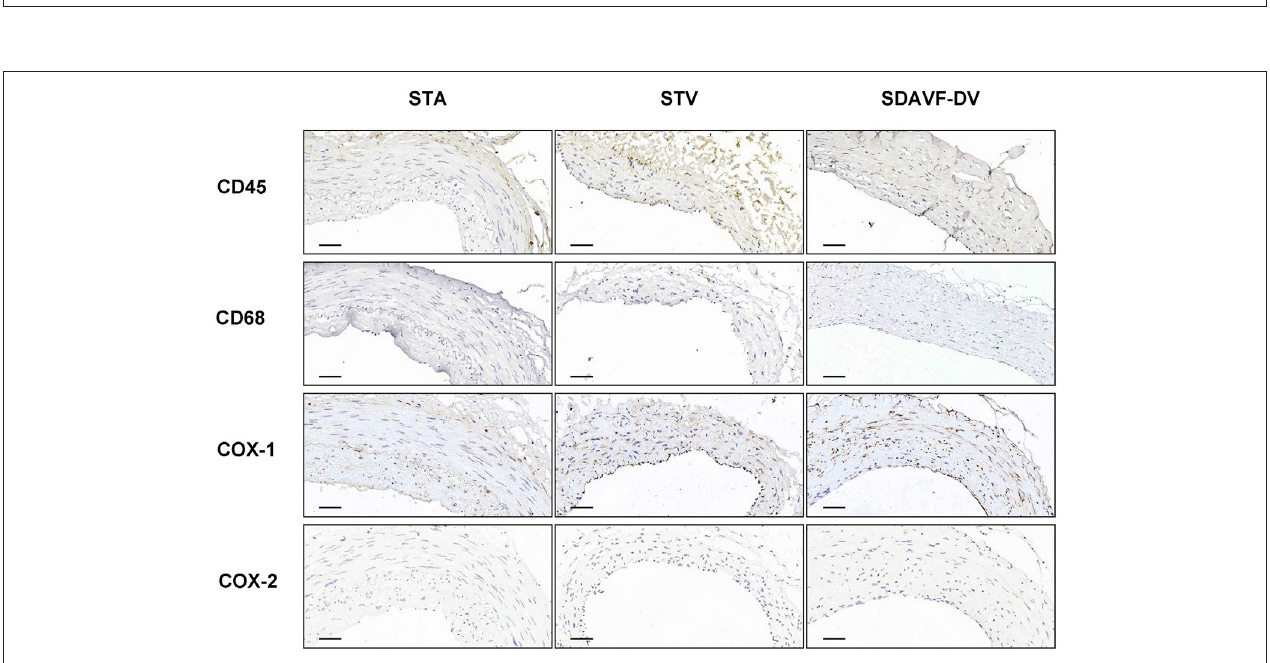
FIGURE 3 | CD45, CD68, COX-1 and COX-2 immunohistochemistry. Histological features of the STA, STV and SDAVF-DV are shown in the photomicrographs. Representative photomicrographs showing HE-stained and Masson’s trichrome-stained vascular tissues are presented. CD45, CD68, COX-1 and COX-2 were detected by immunohistochemistry. Scale bar = 50 µ m in immunohistochemistry.